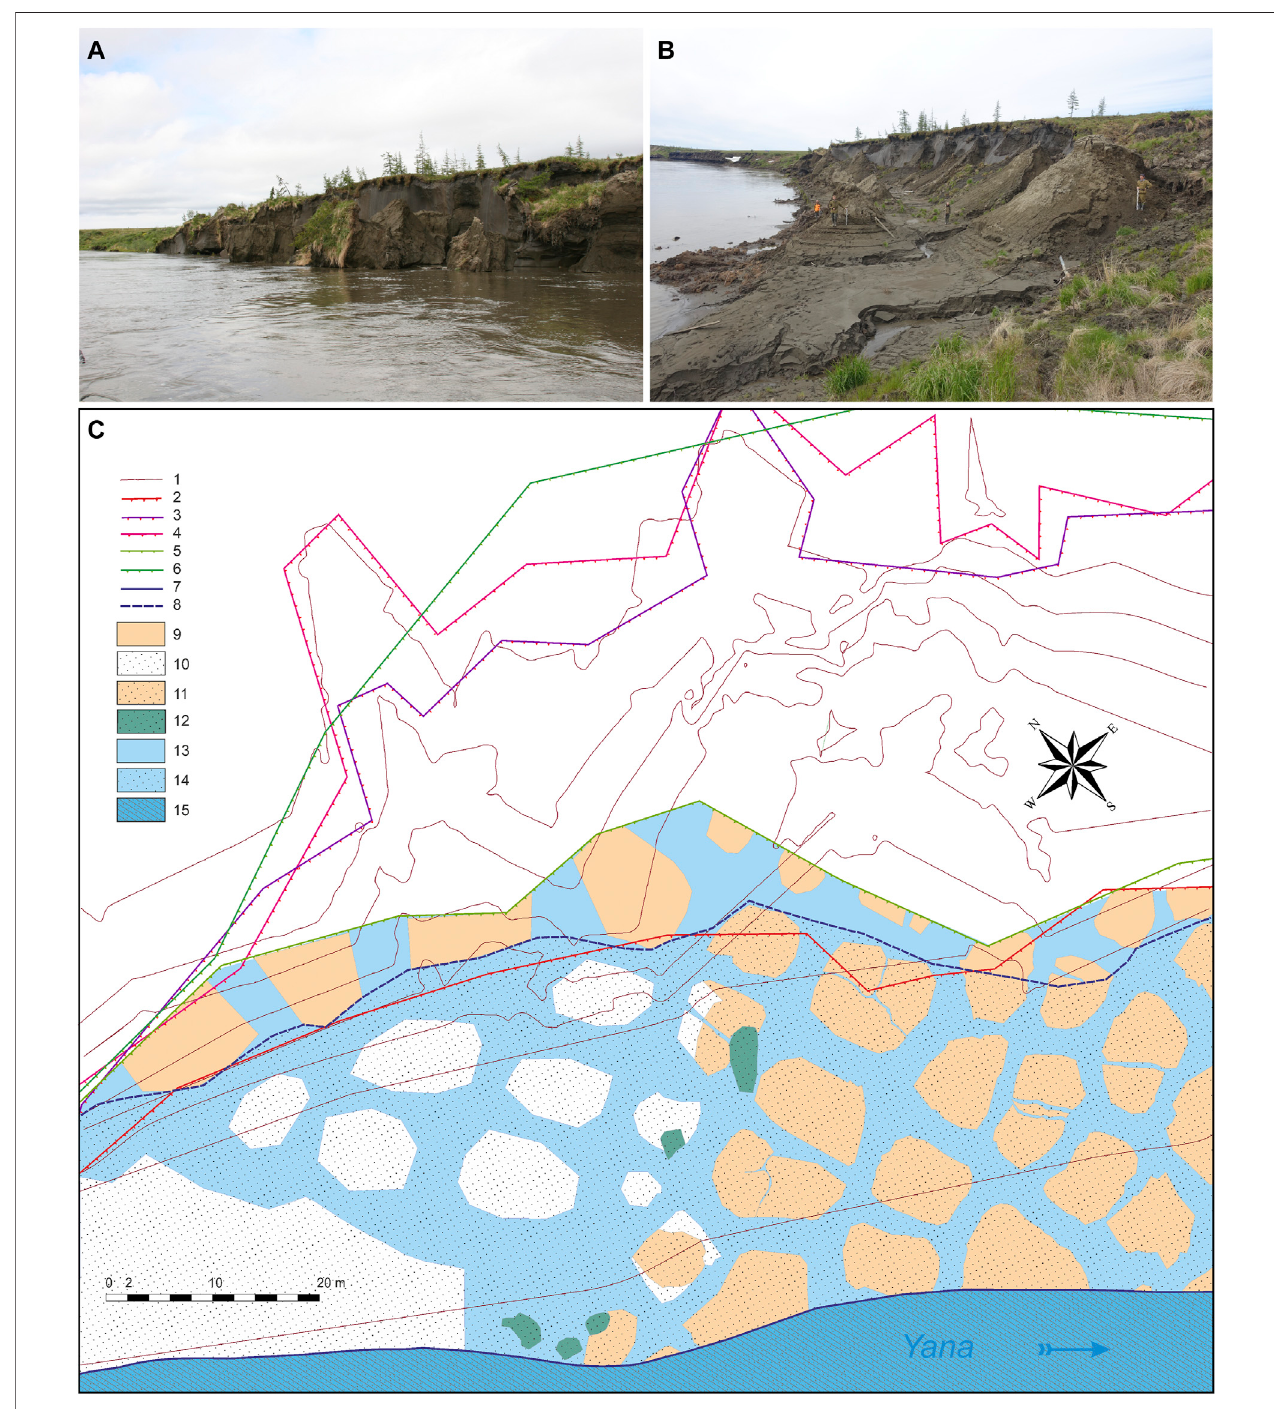
FIGURE 4 | Destruction of the left river bank in the area of the Northern Point area of the Yana complex of sites by the thermal erosion: (A) – the catastrophic collapse of large blocks of the bank deposits between Northern Point and Yana B zone in 2016; (B) view of the same area in 2017 during low water stand; (C) – development of the lateral erosion observed on the river bank in the western portion of the excavation at the Northern Point area based on topographic survey. Illustrationkey:1 — contourlinesaregivenin2 mincrements;2 – 6 — locationofthesecondterracebrowrecordedindifferentobservationyears(2 — 2007;3 — 2013; 4 — 2014; 5 — June 2016; 6 — September 2016); 7 — the lowest water level in 2016; 8 — the highest water level of 2016; 9 — permafrost polygons holding in situ cultural layer; 10 — modern alluvium covering thawed permafrost polygons; 11 — modern alluvium covering permafrost polygons, in which the cultural layer was studied during excavationsin2003 – 2015;12 — collapsedfrozenblocks,whichcontainedaculturallayer,studiedinasub- “ insitu ” positionin2016;13 — polygonalicewedgesinfrozen cliffs; 14 — thawed polygonal ice wedge covered with modern alluvium; 15 — channel alluvium. Compiled by S.G. Kritsuk and E.Y. Pavlova.